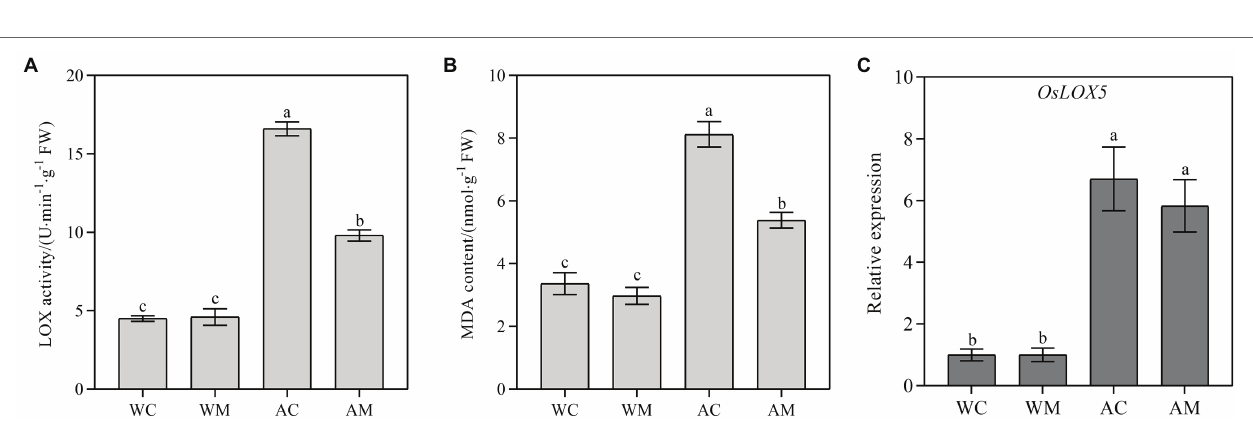
FIGURE 3 | Effects of exogenous MT on O 2·– production rate and H 2 O 2 content. (A) O 2·– production rate; (B) H 2 O 2 content. Data represent means ± SEs of three replicate samples. Different letters denote significant differences ( n = 3, and p < 0.05). WC, control; WM, control pretreated with MT; AC, alkaline stress; and AM, alkaline-stressed plants pretreated with MT.